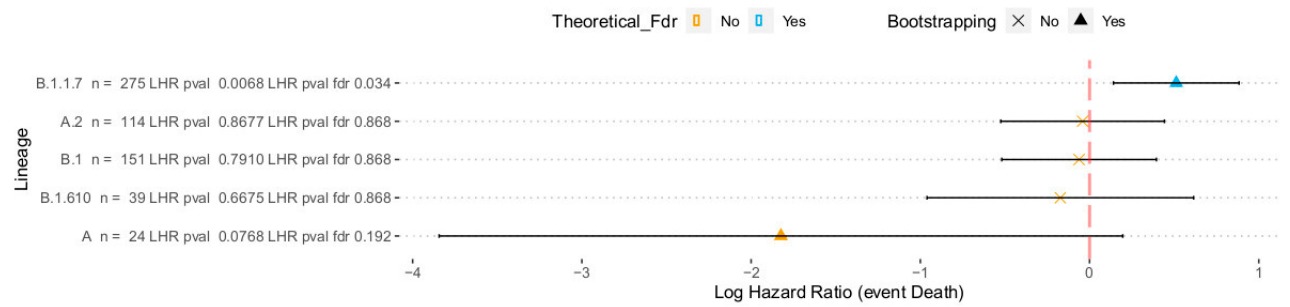
6 of 14 Figure 1. Circulation of the five SARS-CoV-2 variants eligible for the causal analysis in Andalusia ( upper panel ) and Spain ( lower panel ). Figure 2 shows the log hazard ratios obtained for the different lineages. Only one of them, the alpha variant (B.1.1.7), has rendered a significant impact on patient survival (log Hazard Ratio, LHR, of 0.51, with a confidence interval (CI) = [0.14,0.88]). These results are in agreement with recent observations reporting that this variant suppresses the innate